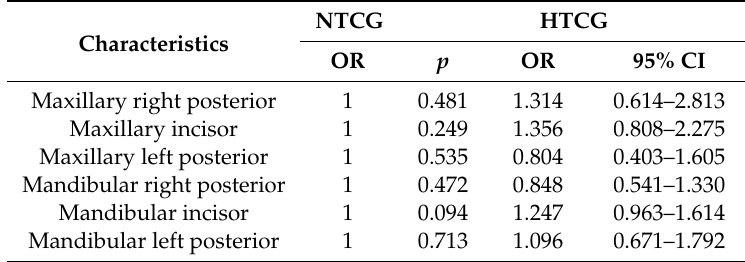
Table 3. Community periodontal index (CPI) by total cholesterol